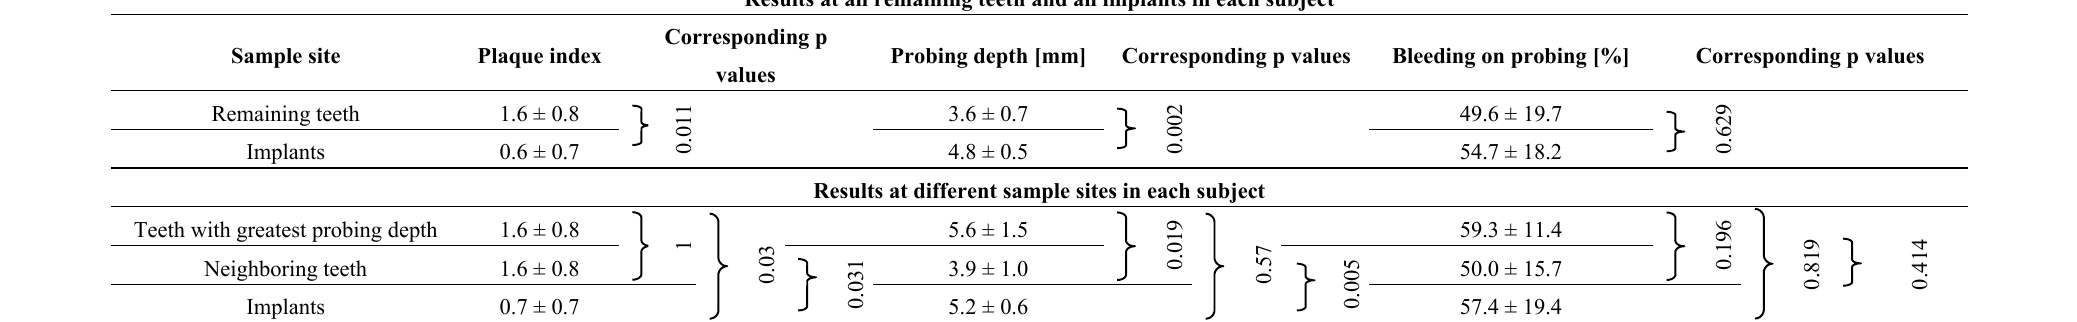
Neighboring teeth